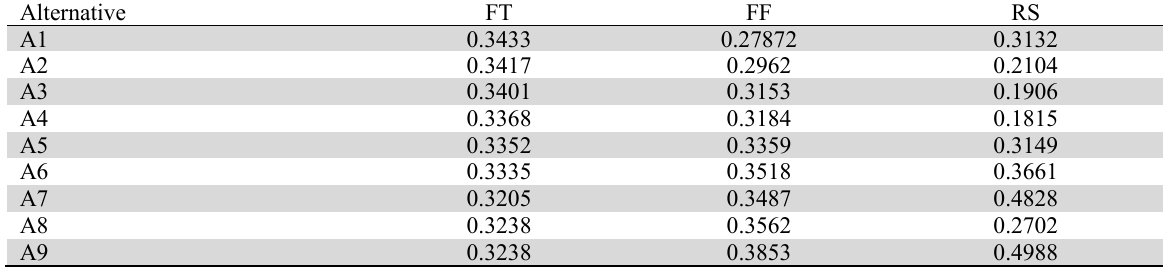
Normalized decision matrix